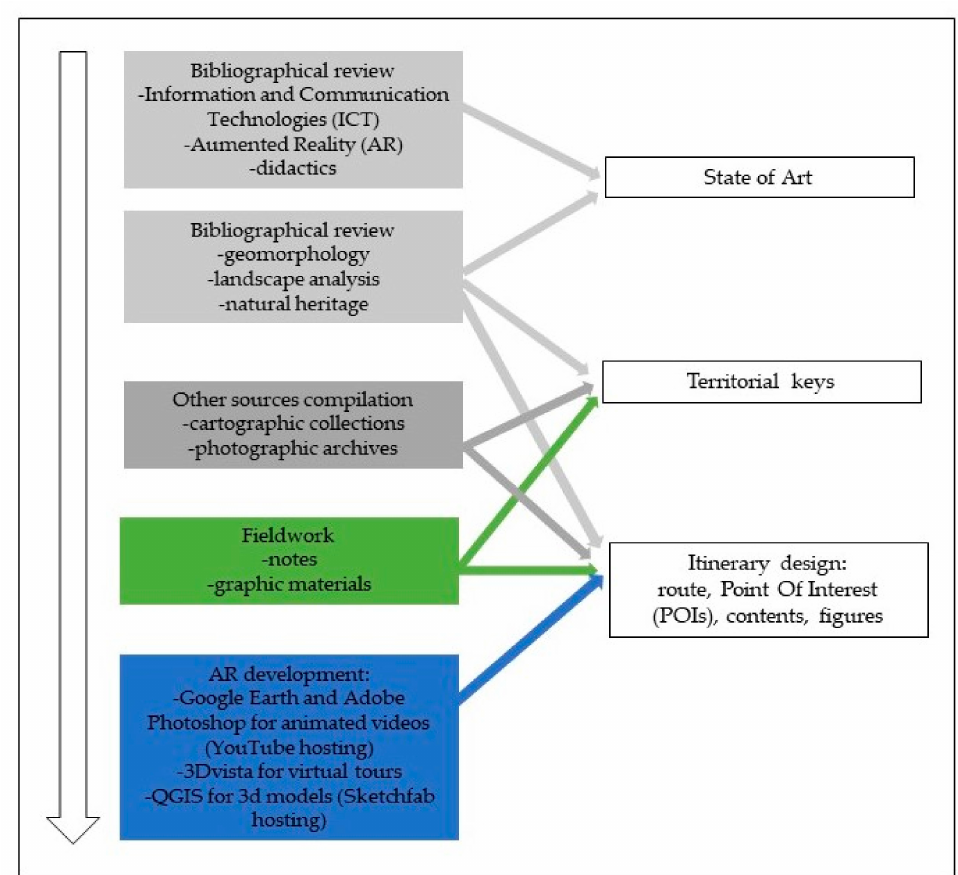
Figure 4. Workflow depicting all the phases of the